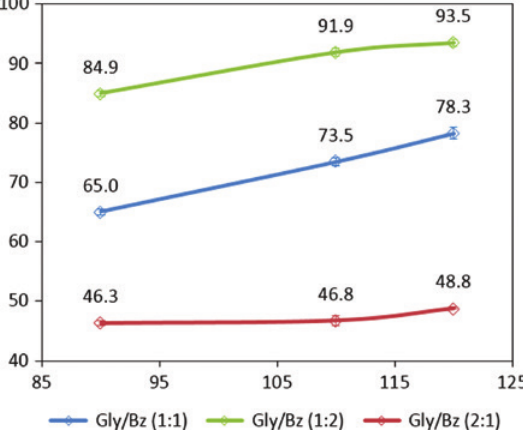
Figure 1: Glycerol conversion (%) versus different temperatures ( ° C) and reagents ratios.